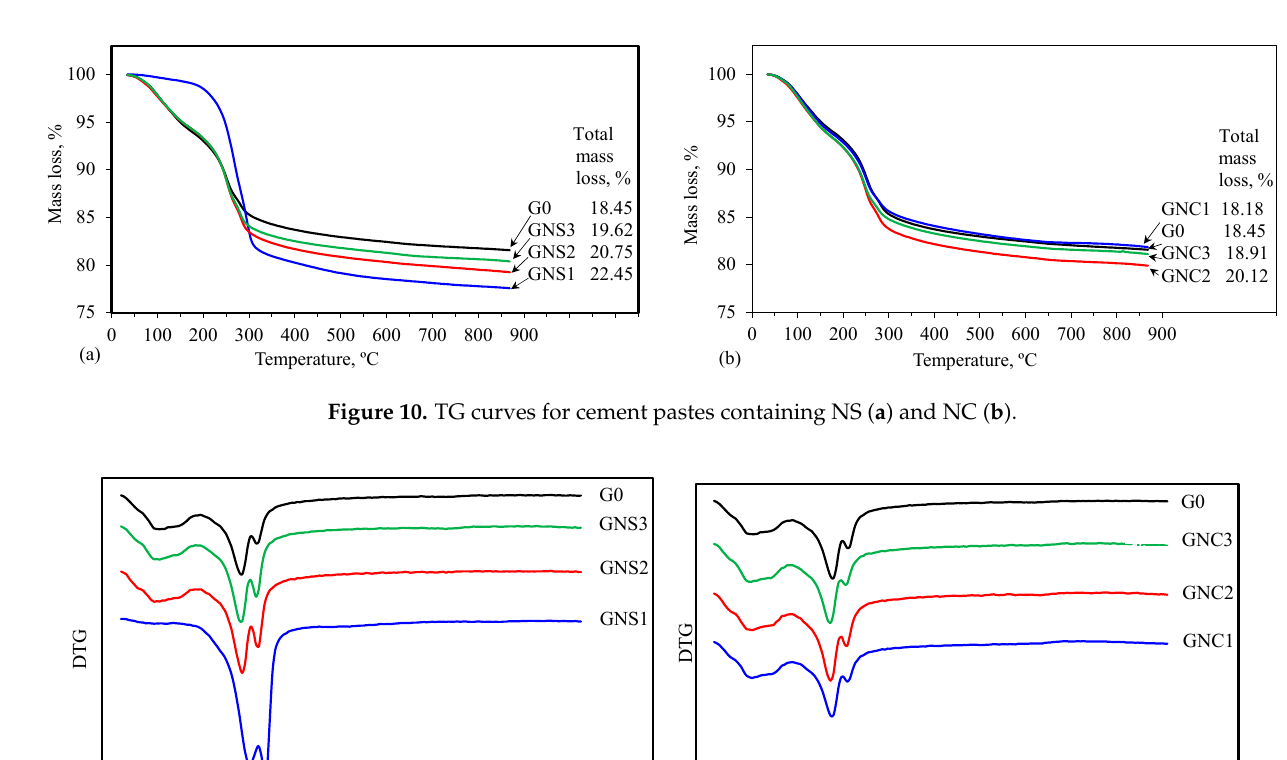
Figure 9. Exemplary TG and DTG curves for G0 sample and Δ m1– Δ m4—explanations in the text.